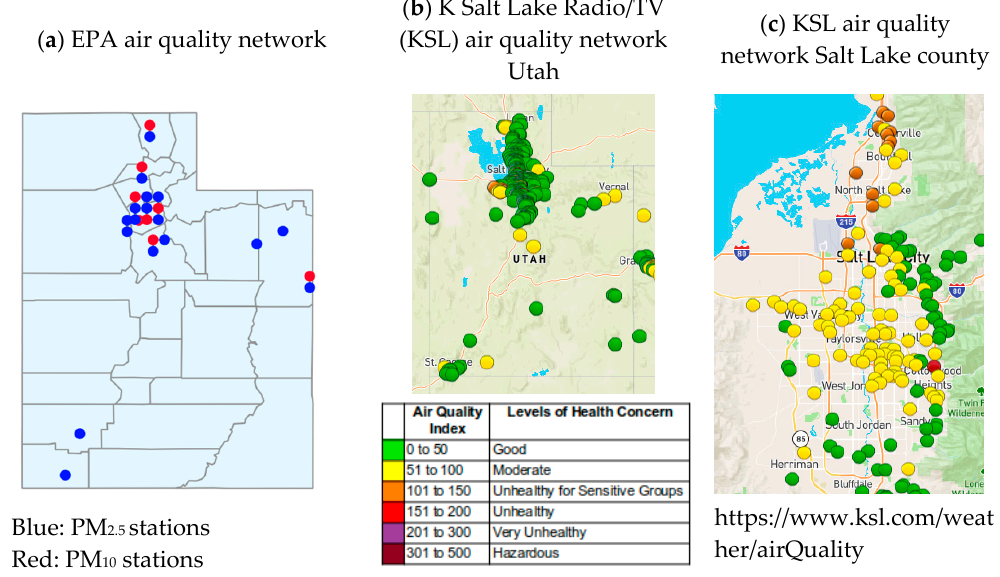
Figure 6. Maps showing locations of ( a ) EPA and ( b ) KSL Air quality monitoring stations within Utah and ( c ) Salt Lake County.